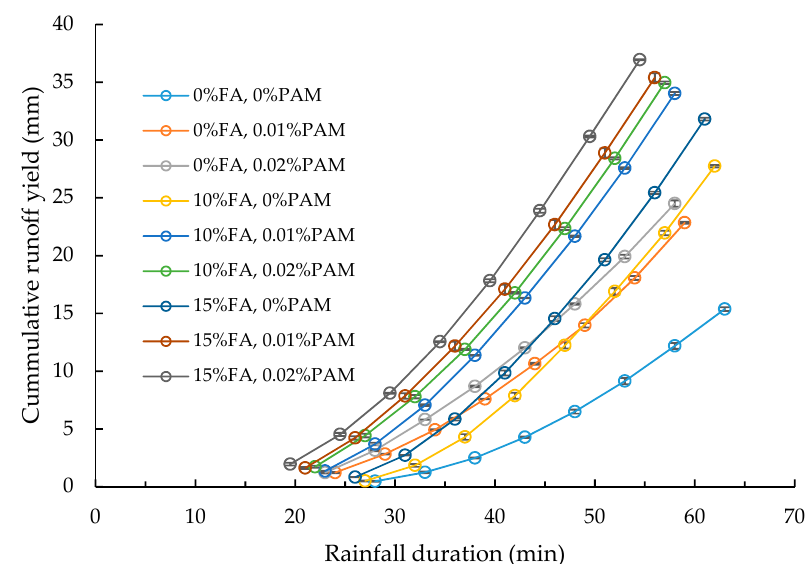
Figure 3. Changes in cumulative runoff yield with rainfall duration for different treatments. The error bars represent one standard deviation ( n = 3).